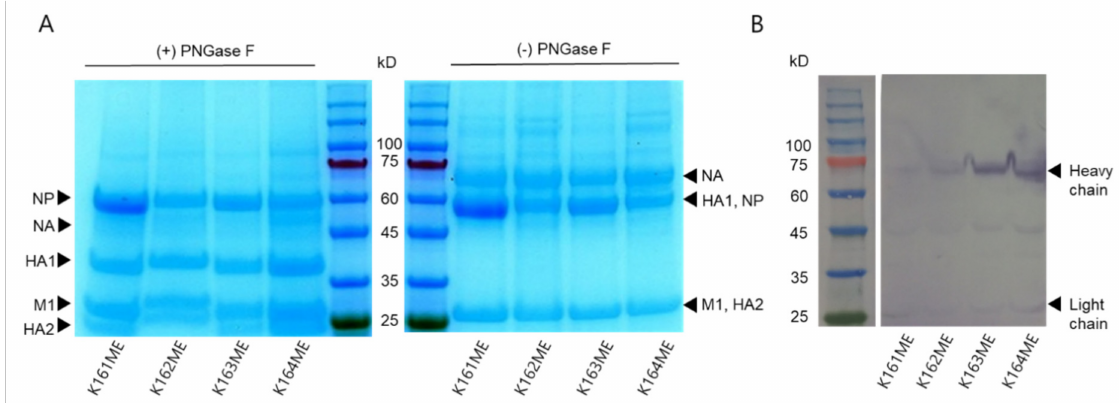
Figure 9. Different amounts of viral proteins and interactions with sialoproteins in allantoic fluids. The harvested allantoic fluid of SPF ECEs infected with vaccine candidate viruses was mixed with OptiPrep density gradient medium and ultracentrifuged at 45,000 rpm for 1 h. ( A ) Total viral protein purified and deglycosylated by PNGase F of vaccine candidate viruses was separated by SDS-PAGE and stained with Coomassie blue. ( B ) Separated protein-transferred membranes were blocked with 5% skim milk and treated with HRP-conjugated goat anti-chicken IgG (IgY) antibody for 1 h. HRP was developed with TMB solution, and chicken IgY was